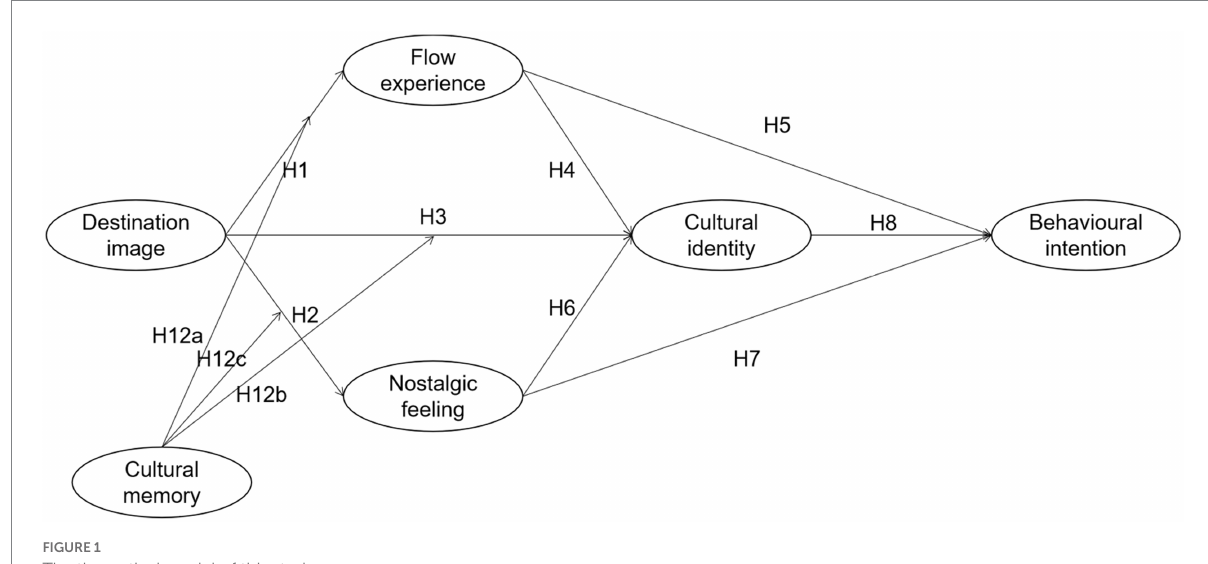
FIGURE 1 The theoretical model of this